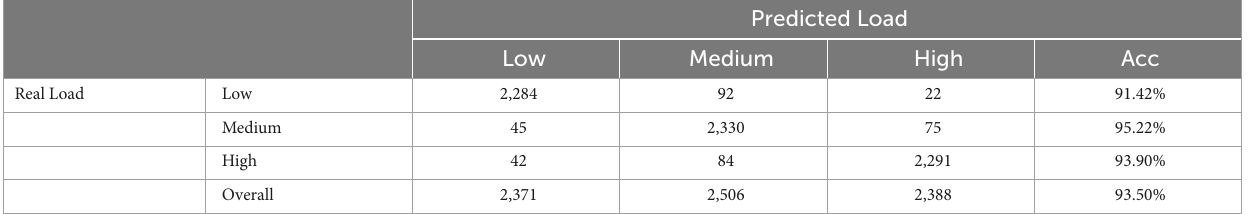
TABLE 5 Results of movement classification using our proposed two-step